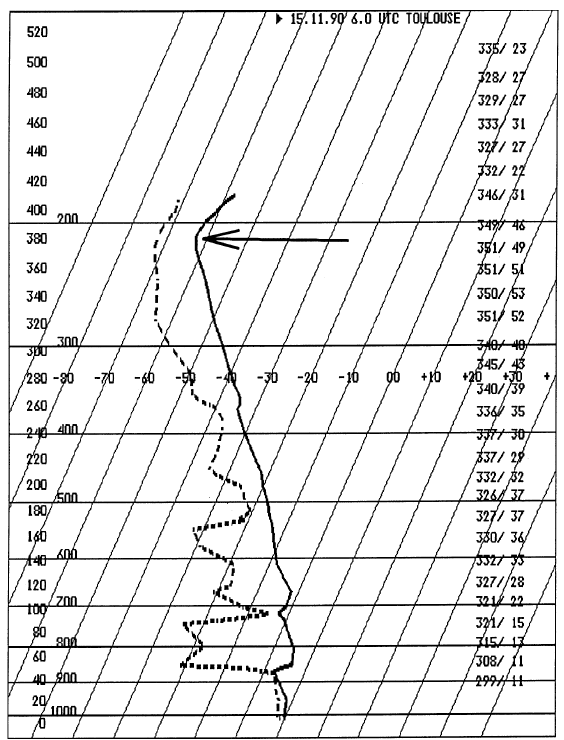
Fig. 9. Same as Fig. 8, but for 15 November at 06:00 UT